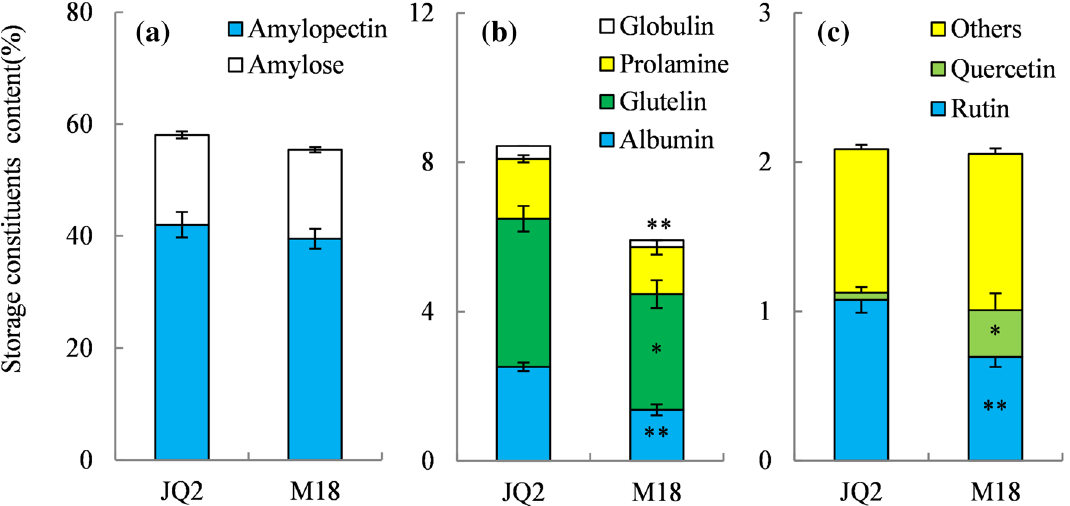
Figure 2. The levels of starch ( a ), proteins ( b ) and flavonoids ( c ) in grain of Tartary buckwheat. * and ** indicate significant differences at 0.05 and 0.01, respectively, according to independent samples t -test (n =